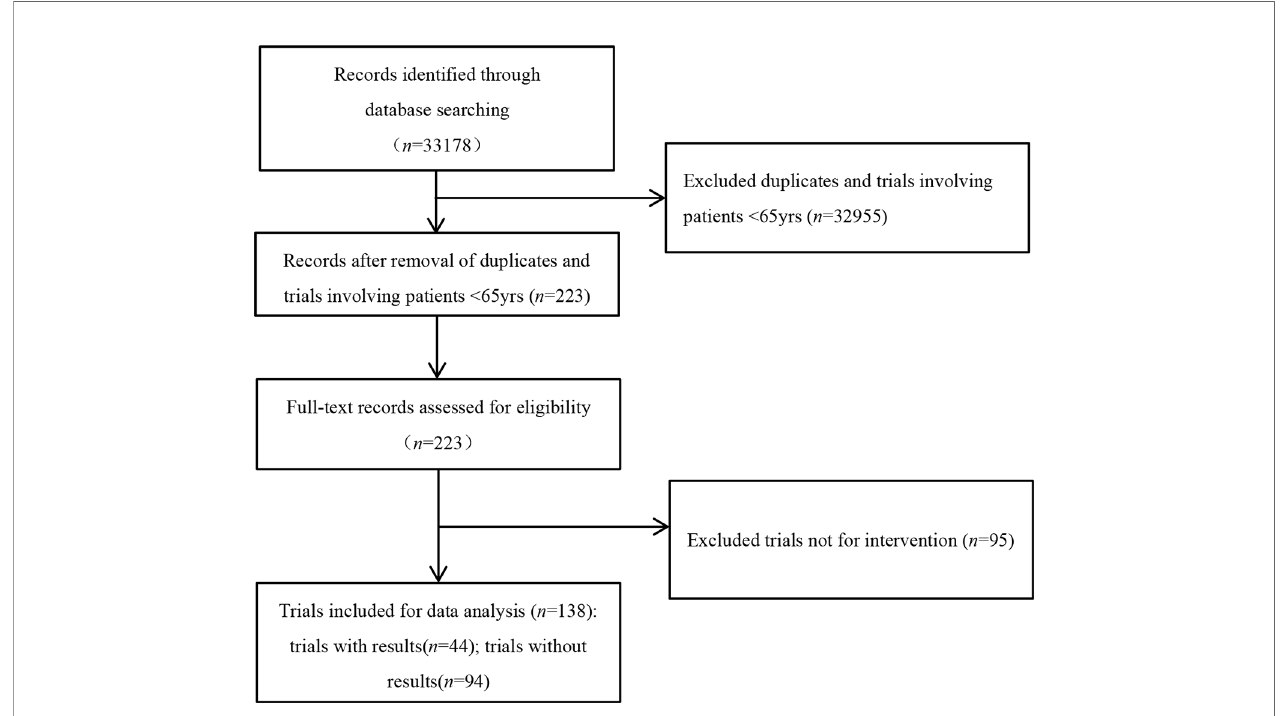
FIGURE 1 | Flowchart of selection